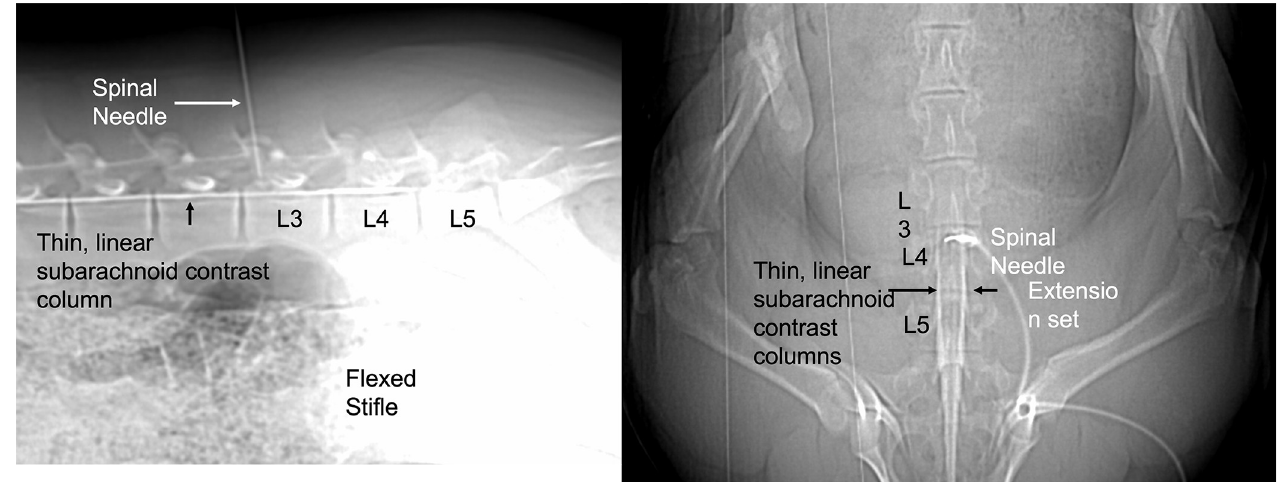
Fig 2. Sagittal and dorsal scout showing a test injection and linear contrast column filling of the ventral portion of the subarachnoid space. This indicates accurate needle placement so that the entire volume of contrast medium may then be injected. An epidural injection occurred in two instances and needle replacement resulted in correct injection into the subarachnoid